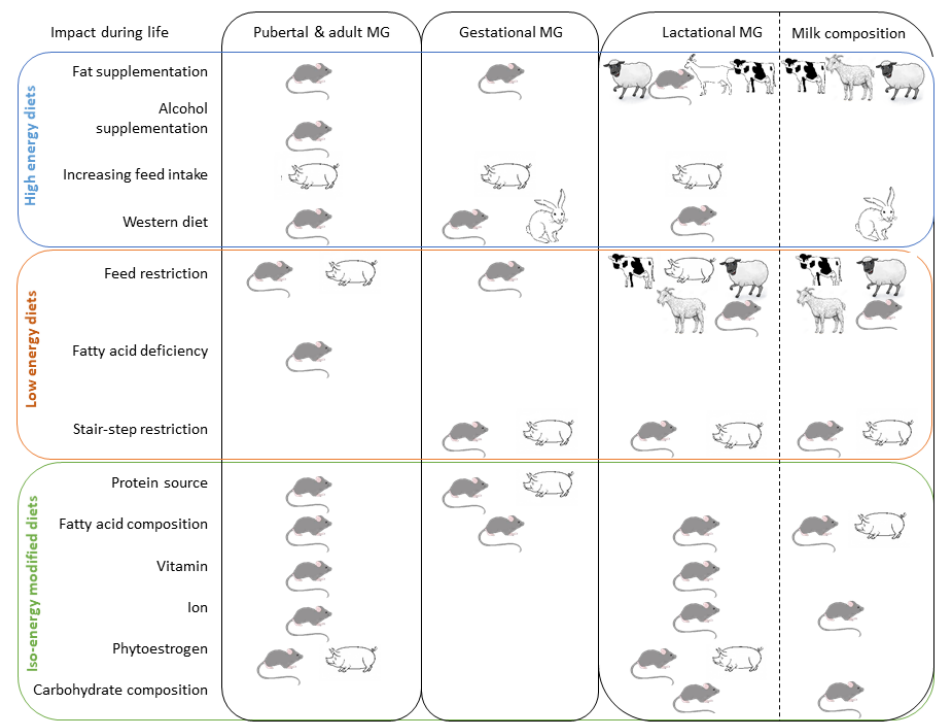
Figure 1. Summary of the discussion of the impact of nutrition on mammary development and milk composition, according to species, physiological stages, and type of diet used.